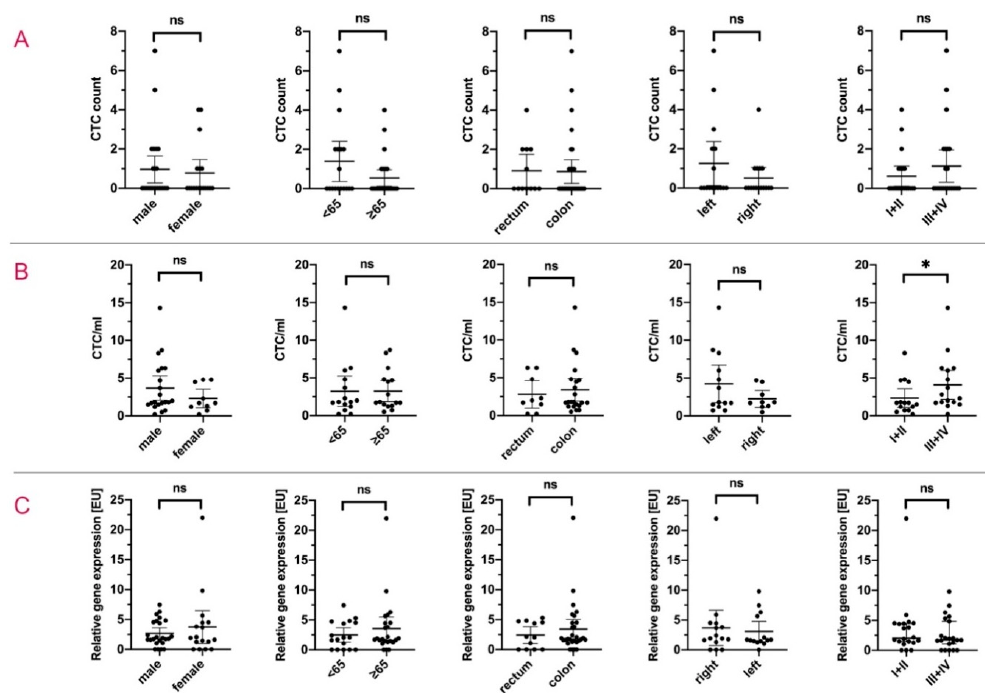
Figure 3. Congruence of CTC quantity and clinico-pathological characteristics. CTC enumeration data of the entire patient cohort was assessed by ( A ) NYONE ® , ( B ) ScreenCell ® and ( C ) CK20-qRT-PCR and analysed in terms of the association between the prevalence of CTC and clinico-pathological data. The bar between the percentiles represents the mean value for CTC detection within each subset of analysed samples. <65 and ≥ 65 refers to the patients’ age in years at the time of blood drawl; left and right refers to the site of colon cancer. * p < 0.05. Table 2. Association of clinico-pathological patients´ characteristics of the entire study population and CTC quantity partitioned for each technique of CTC detection.